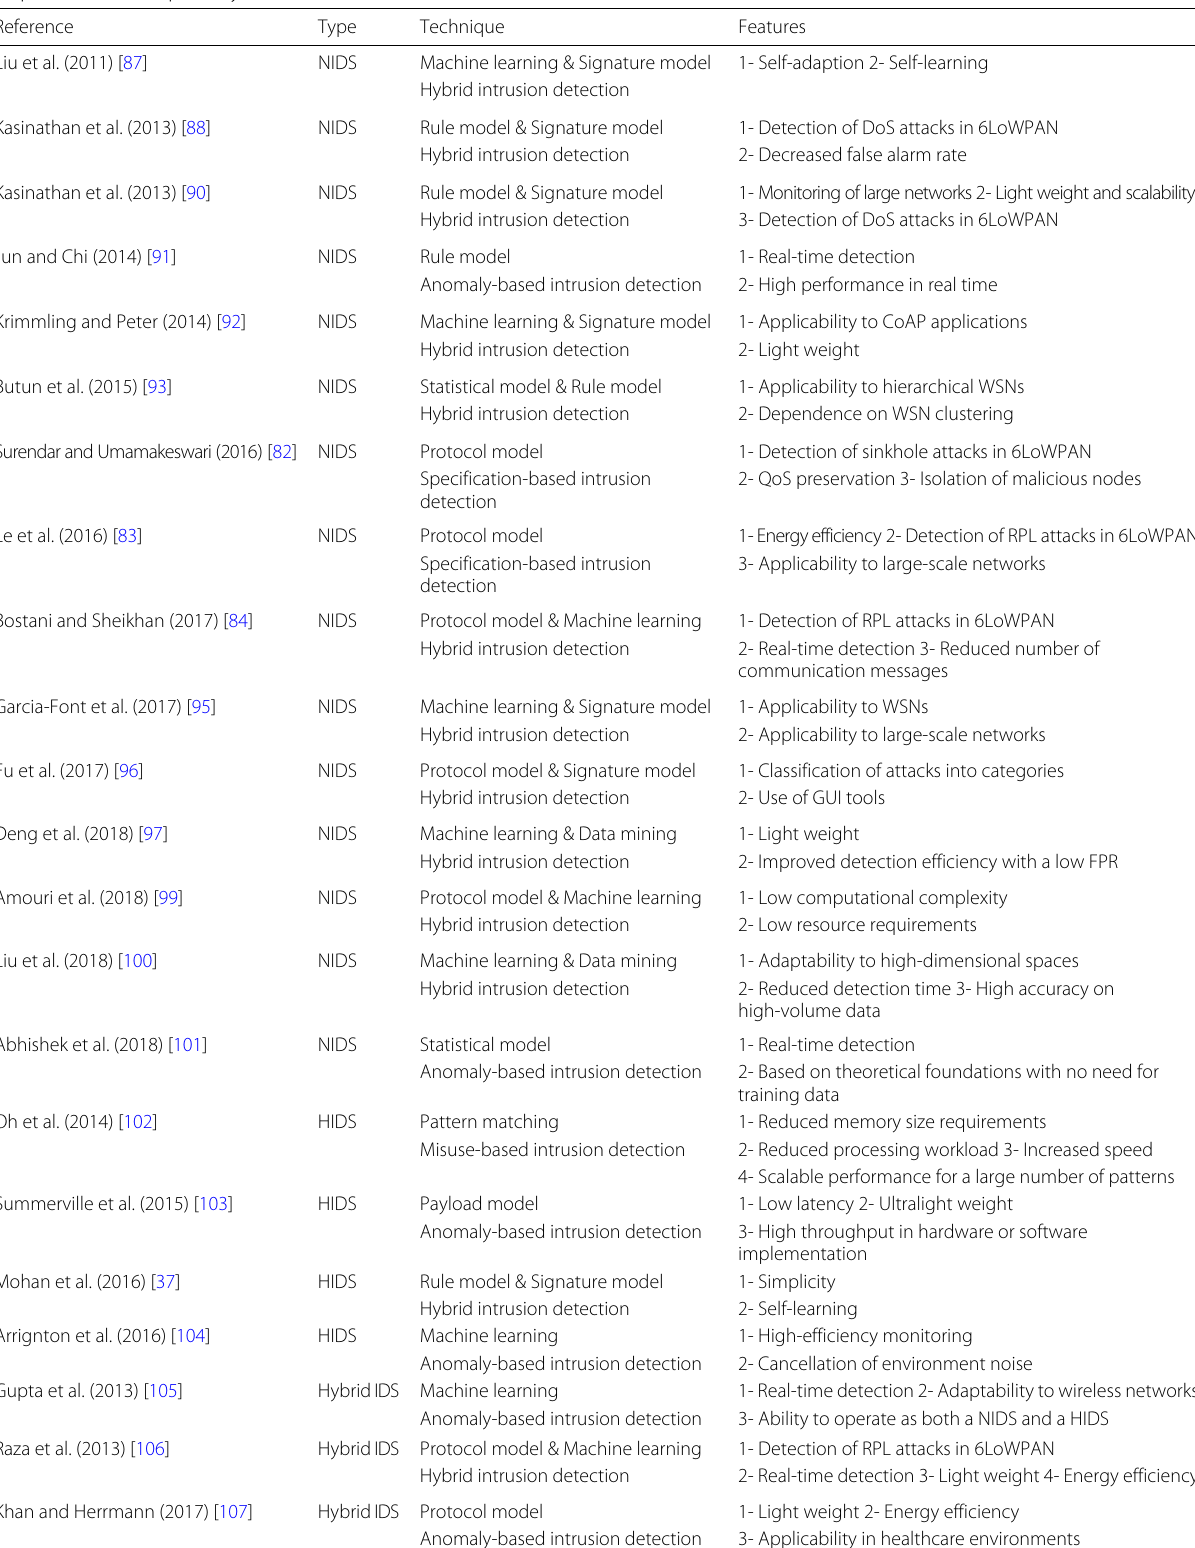
Table 3 A comparison of IDSs designed for IoT systems, with a focus on the types, techniques and features of these systems with respect to their adaptability to IoT-based smart